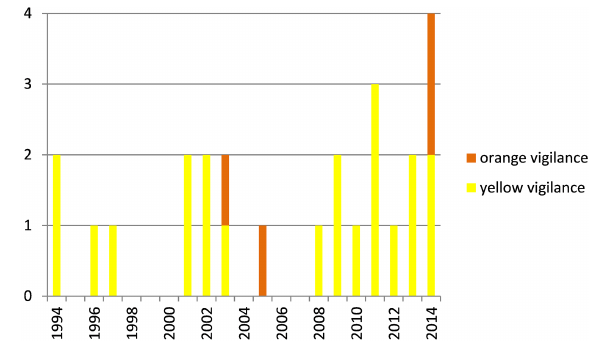
Figure 1. Number of flood events on the Lez catchment between 1994 and 2014. Only the floods responsible for a yellow vigilance level at minimum are registered. No red vigilance level was ob- served during the